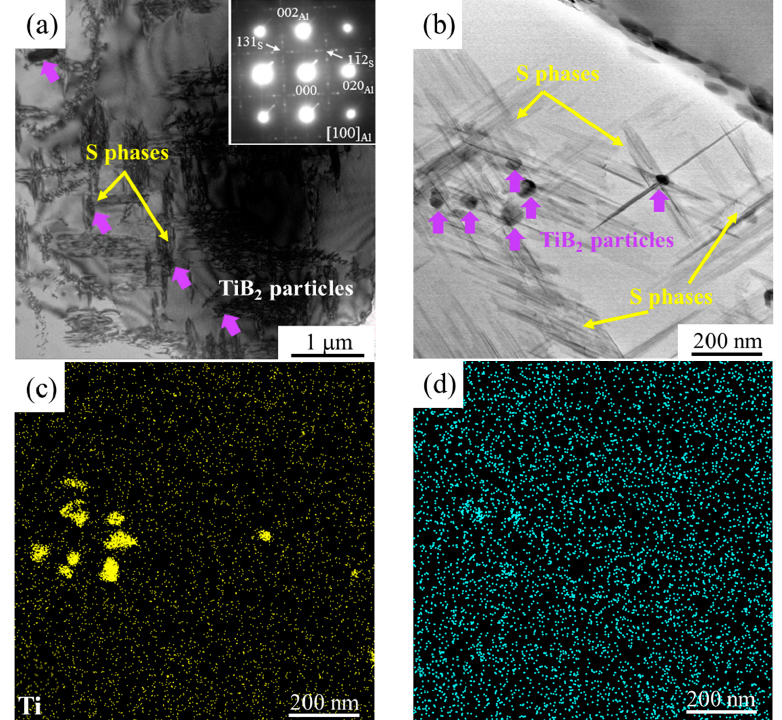
Figure 6. TEM images showing the morphology of S precipitates in TiB 2 /2024 composites under the T6 condition: ( a , b ) bright-field (BF) image, ( c , d ) corresponding element mapping. Inset in ( a ) is